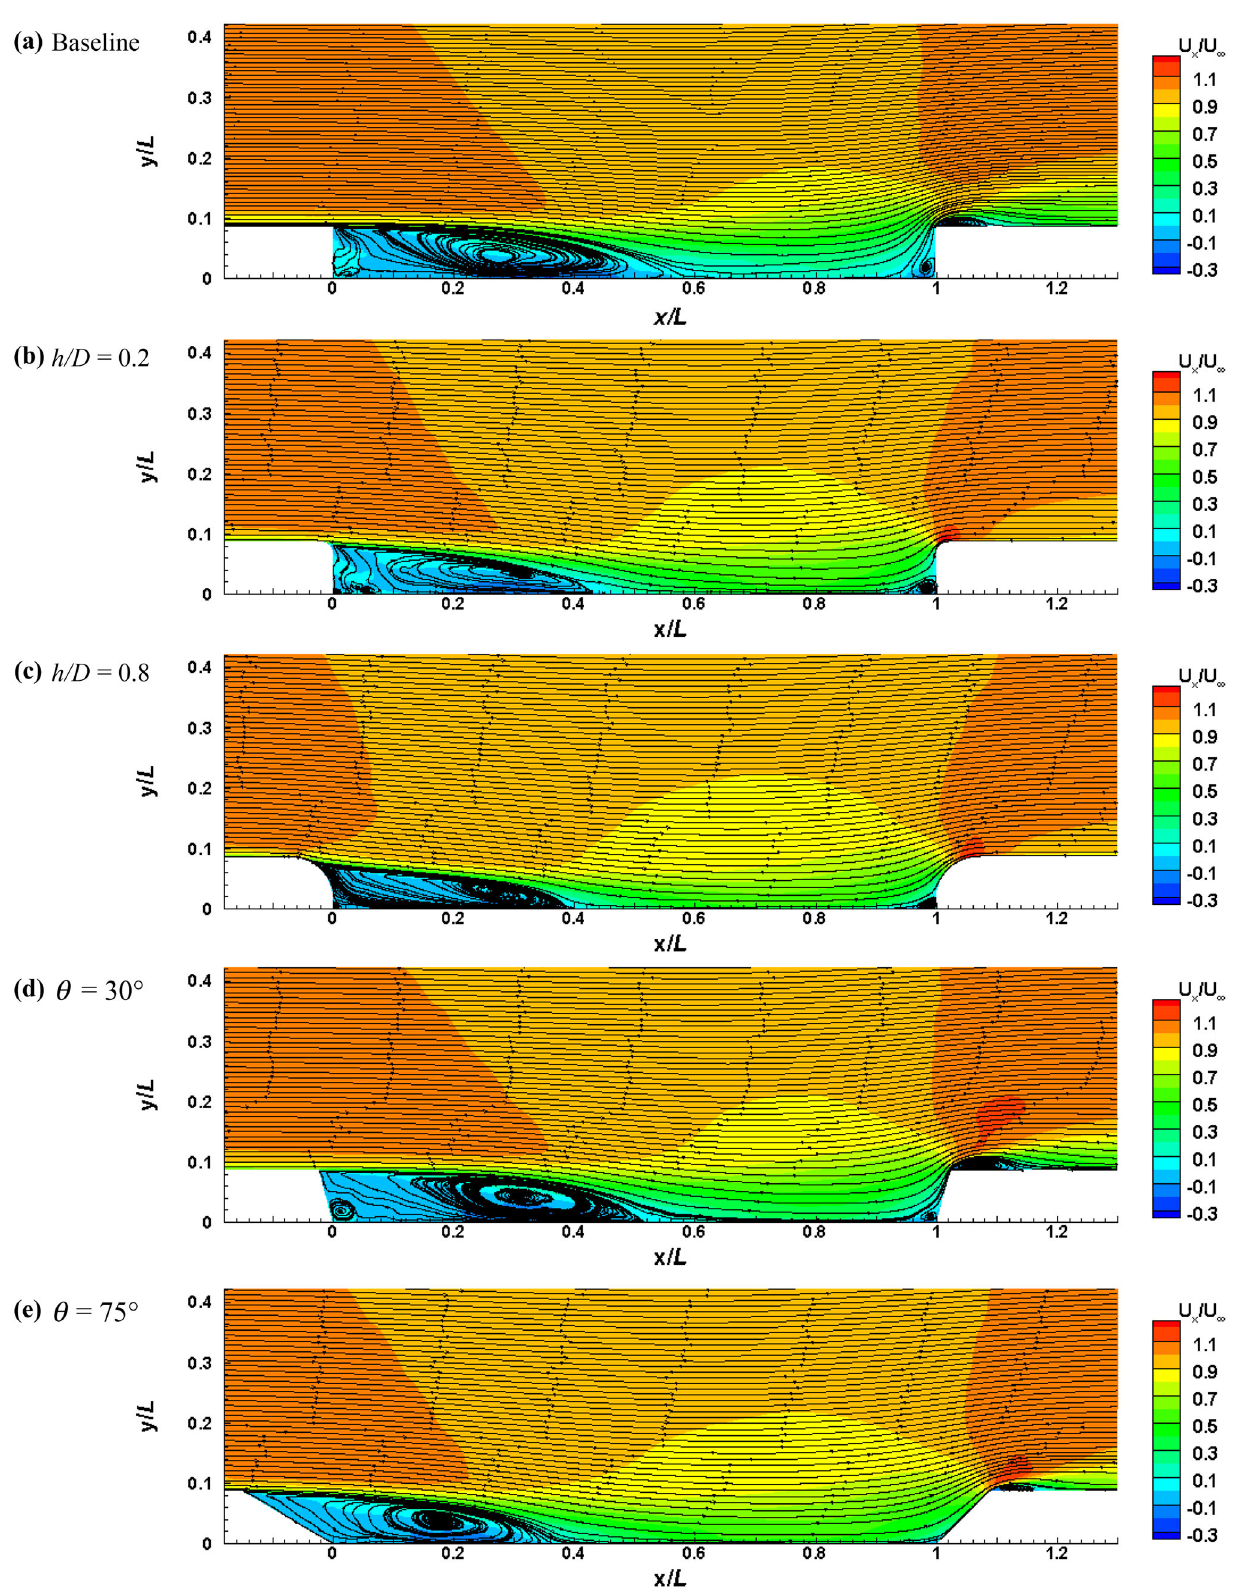
Fig. 9 Mean streamline with time-averaged velocity